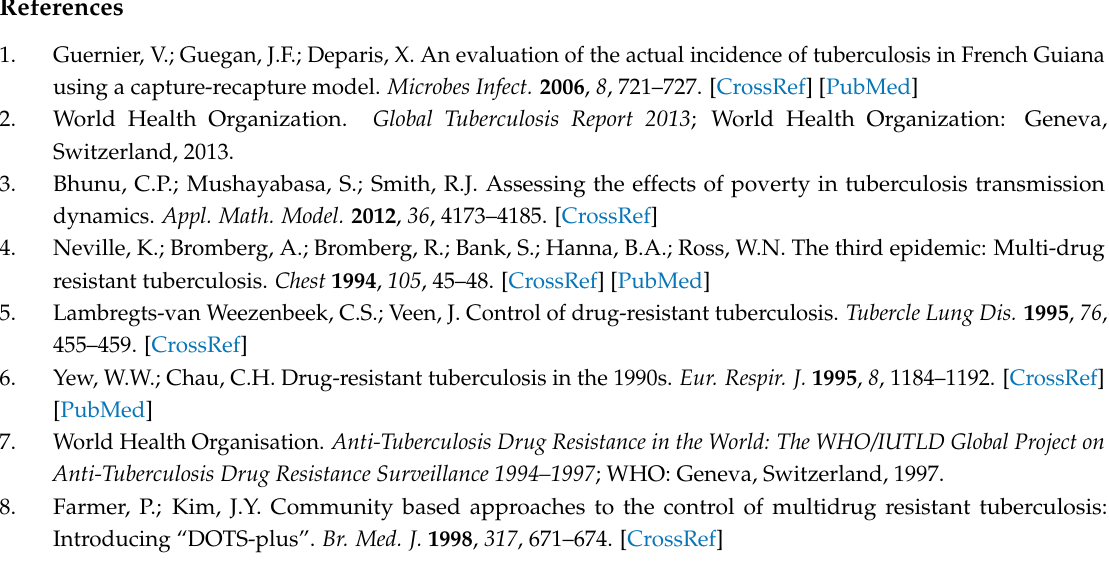
Figure A4. Fitting and forecasting curves for the low income group.